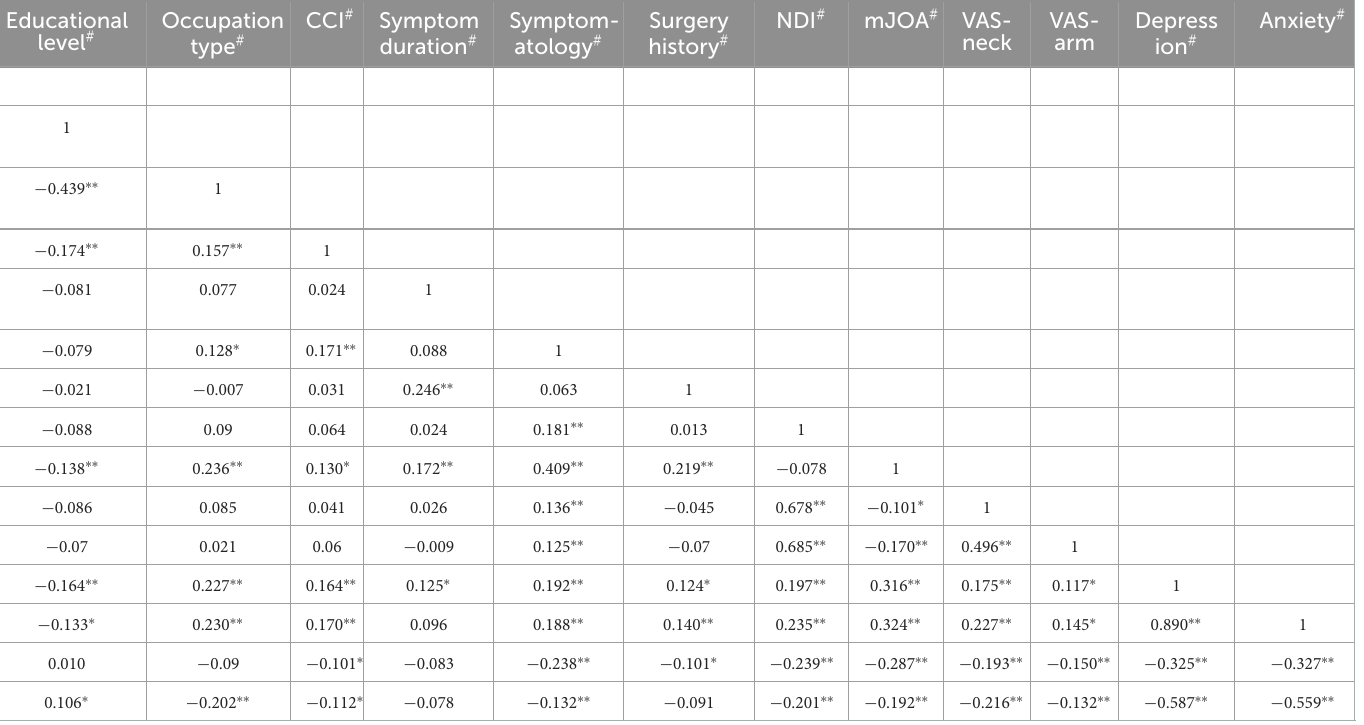
TABLE 2 Bivariate correlations between patient demographic and clinical